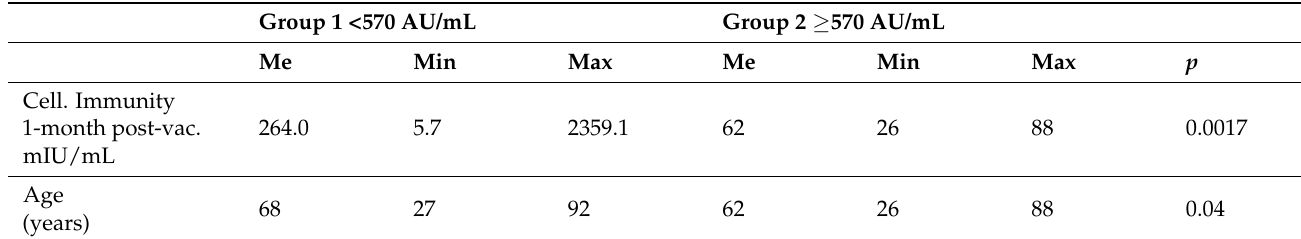
Table 5. Statistically significant differences within the group of patients who had no SARS-CoV-2 infection prior to vaccination. They were divided into patients below and those above or equal the median AB level following vaccination ME 570 AU/mL.